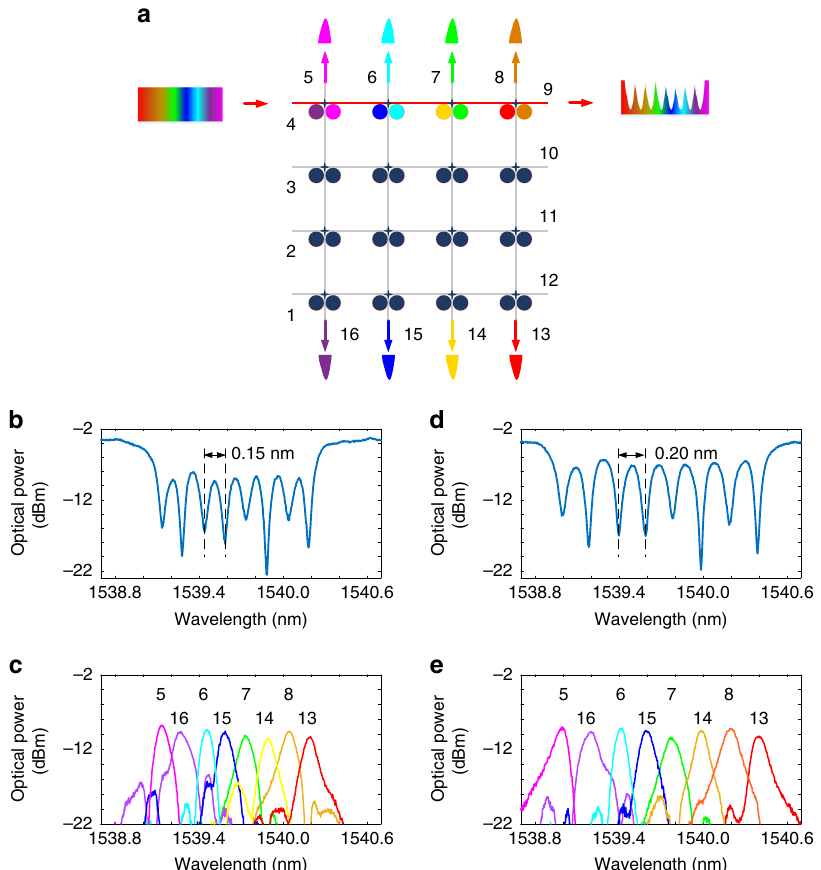
Fig. 2 The FPDA recon fi gured as a wavelength multiplexer/demultiplexer. a Schematic of the FPDA when operating as a wavelength demultiplexer. b Measured transmission spectrum at port 9 of the 8-channel demultiplexer with a channel spacing of 0.15 nm. c Measured transmission spectrum at the 8 drop ports (ports 5 – 8 and 13 – 16) of the demultiplexer with a channel spacing of 0.15 nm. d Measured transmission spectrum at port 9 of the 8-channel demultiplexer with a channel spacing of 0.2 nm. e Measured transmission spectrum at the 8 drop ports (ports 5 – 8 and 13 – 16) of the demultiplexer with a channel spacing of 0.2